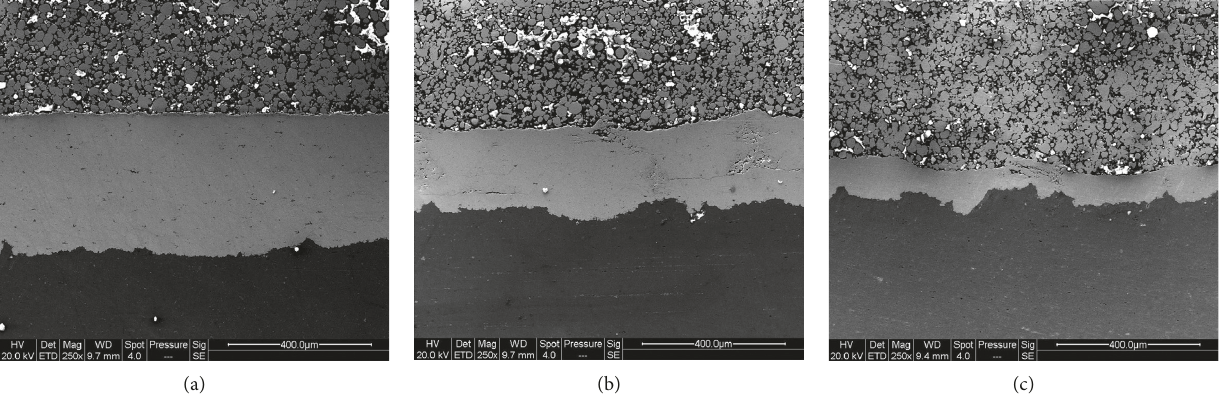
Figure 17: SEM imaging of the cross section of cold-sprayed hBN-Ni MMC coatings produced using (a) unaltered powders, (b) ball-milled powders for 1h, and (c) ball-milled powders for 2h